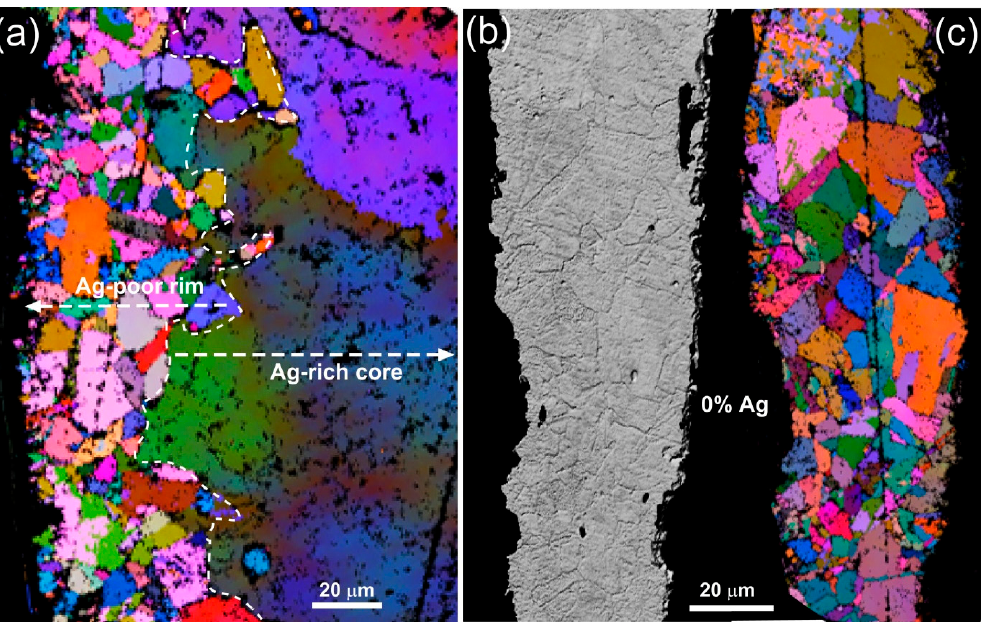
Figure 7. Electron backscatter diffraction maps of Waikaia gold particles, showing the internal grain structures. ( a ) Margin of a particle with large deformed Ag-bearing core grains (right) and smaller Ag-poor recrystallised rim grains (left), with boundary indicated with white dotted line; ( b ) Backscatter electron image; and ( c ) EBSD map, of a section across a flake without a core, consisting of small undeformed Ag-poor gold.